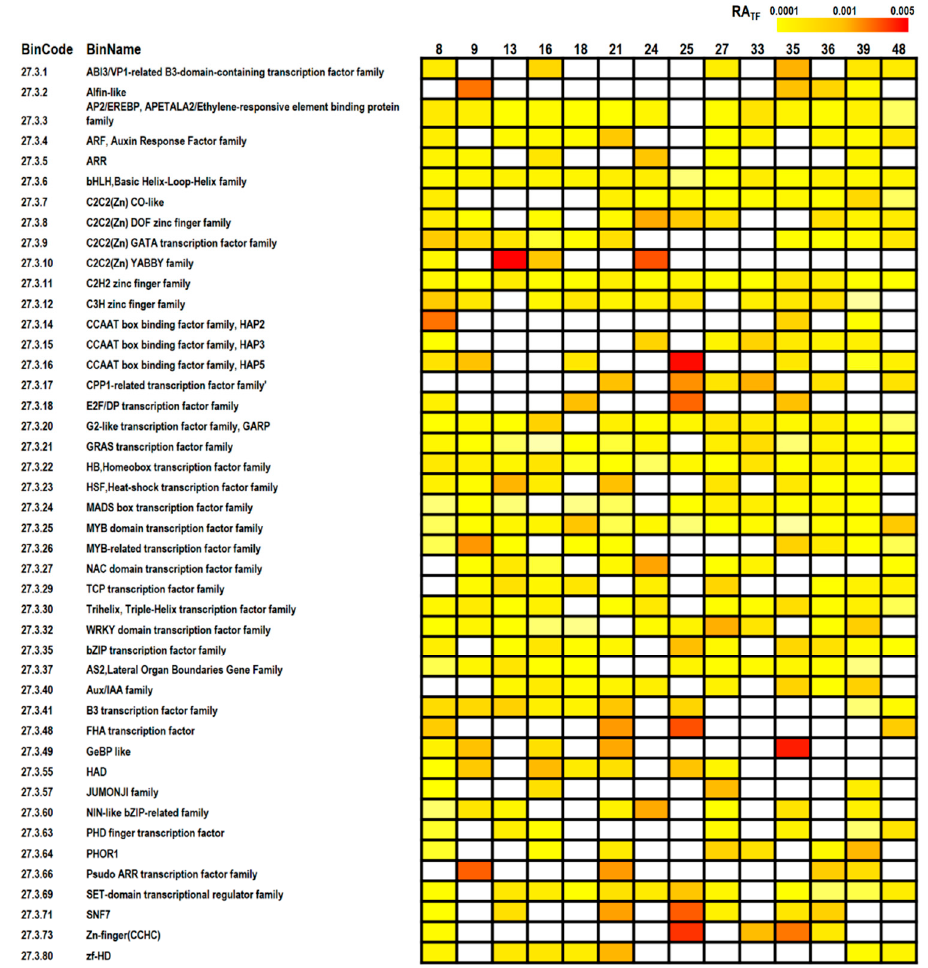
Figure 4. Presence of transcription factors in each cluster. The color depth indicates the abundance of transcription factors of different classes in the clusters.